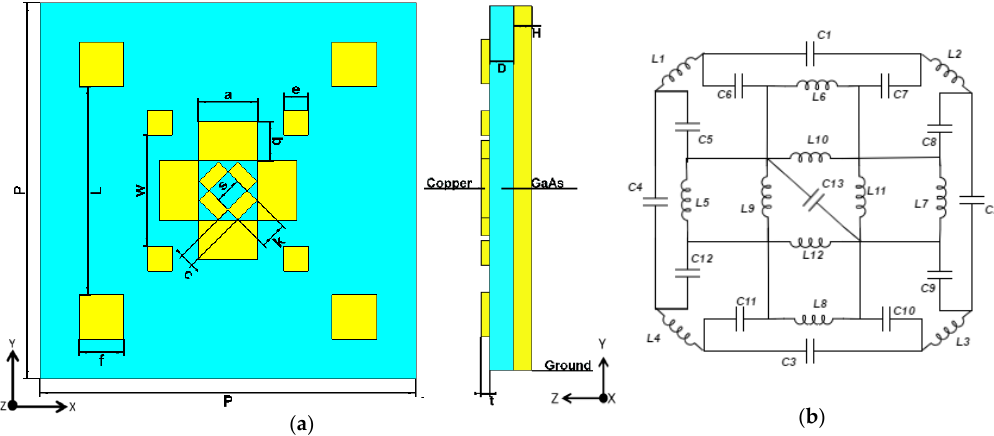
Figure 1. Geometry of the proposed unit cell: ( a ) top view and side view, ( b ) equivalent circuit of the proposed structure.